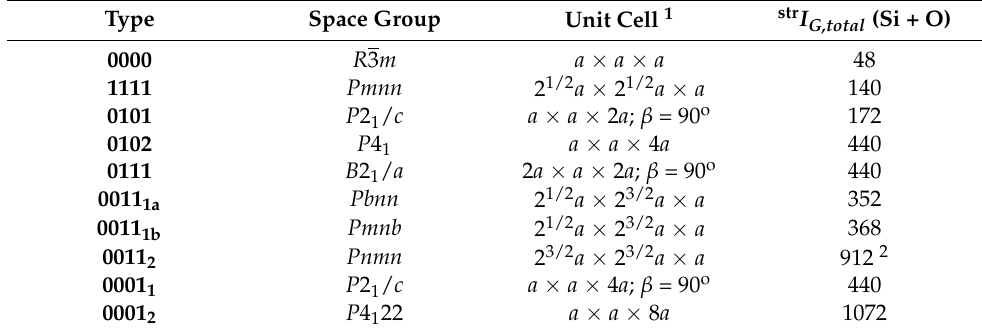
Table 1. Space groups, unit cell parameters and structural complexity values (in bits/cell) for the ten possible lovozerite-type structures.